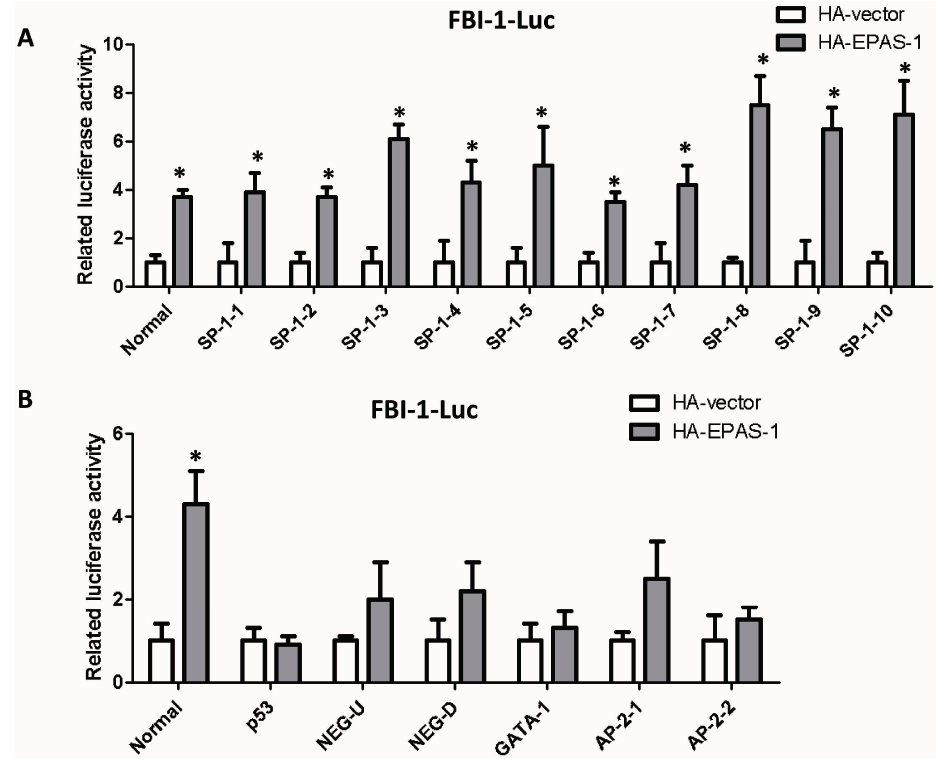
Figure 4. EPAS-1 specifically regulates SP-1-mediated FBI-1 expression. ( A ) EPAS-1 significantly induced the luciferase activities of all the SP-1 binding sites on FBI-1